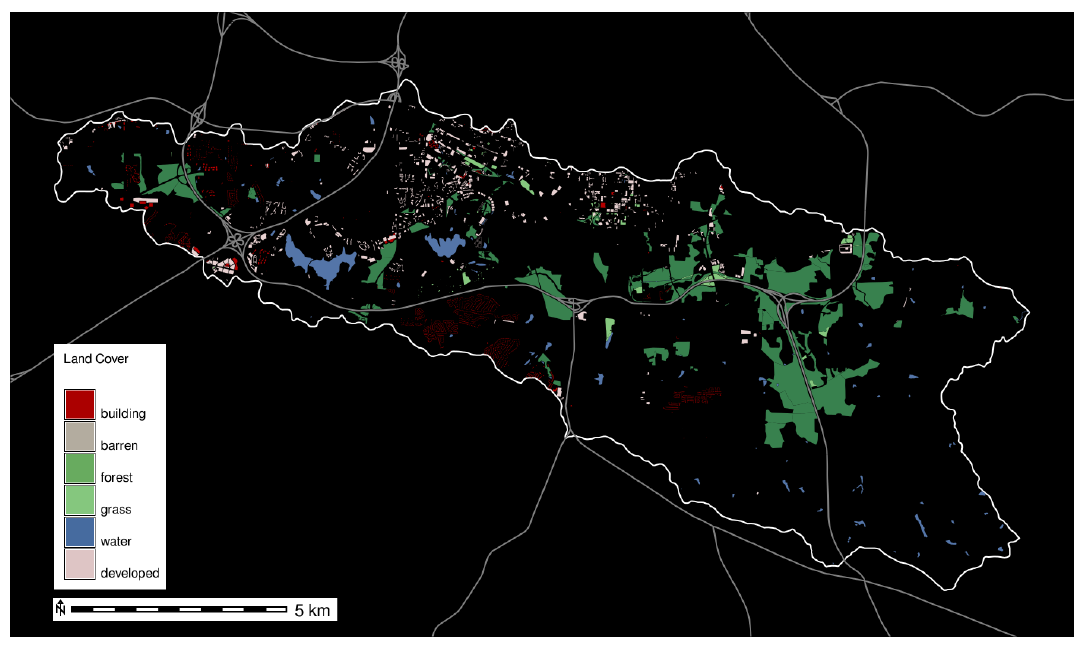
Figure 4. The spatial distributions of land cover samples from OSM inside of Walnut